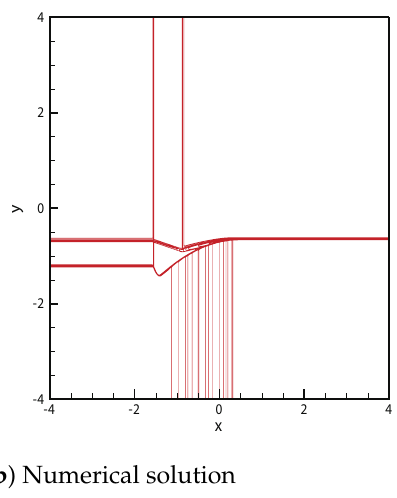
Figure 14. Case 14. JS + JS + R + S δ